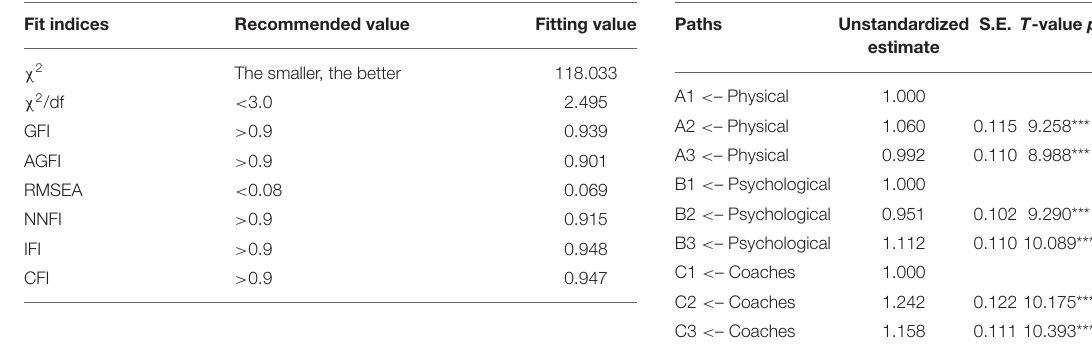
TABLE 5 | Fit index value of SEM. TABLE 6 | CFA parameter estimation results.